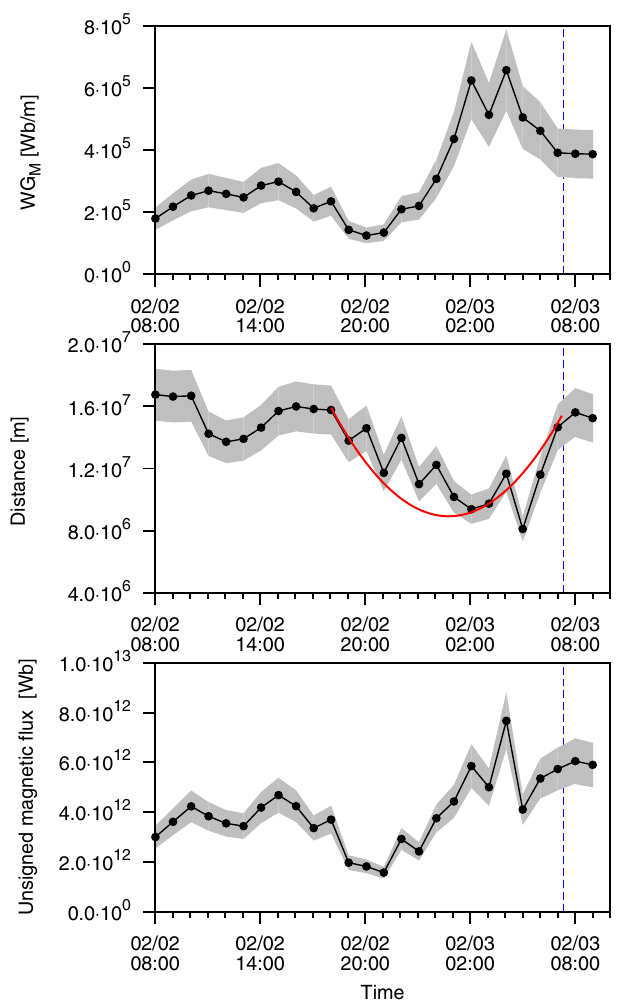
Fig. 3. Evolution of the pre- fl are indicators of the WG M method, similar to those of Figure 2 but for a B-class fl aring event in AR 11967. The estimated error is marked by the shaded grey